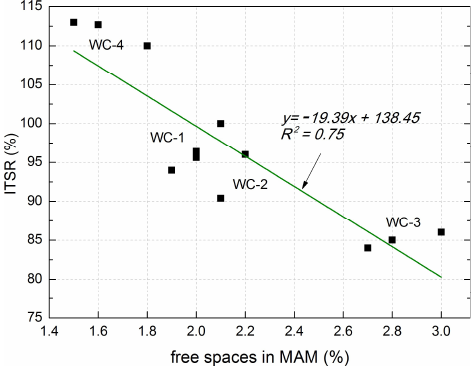
Figure 6. Correlation between the voids in MAM and ITSR.